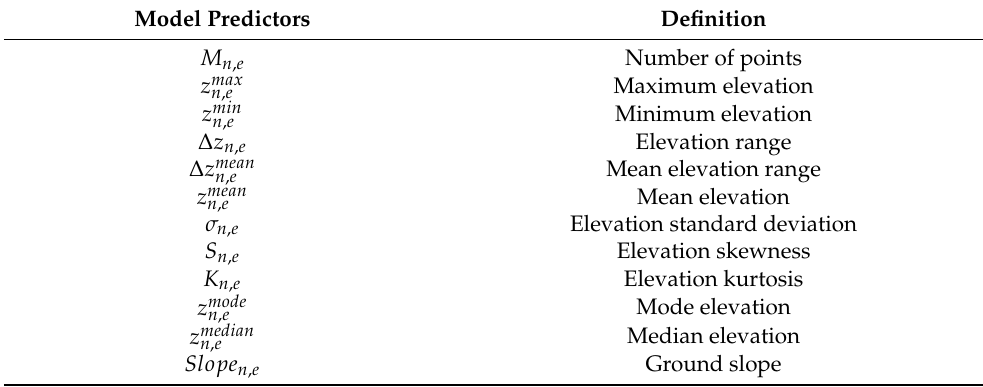
Table 1. List of the model predictors, calculated from the UAV–LIDAR and UAV–DAP point clouds, we used to determine ground elevation using the genetic algorithm, the random forest, and the multiple linear regression (see Section